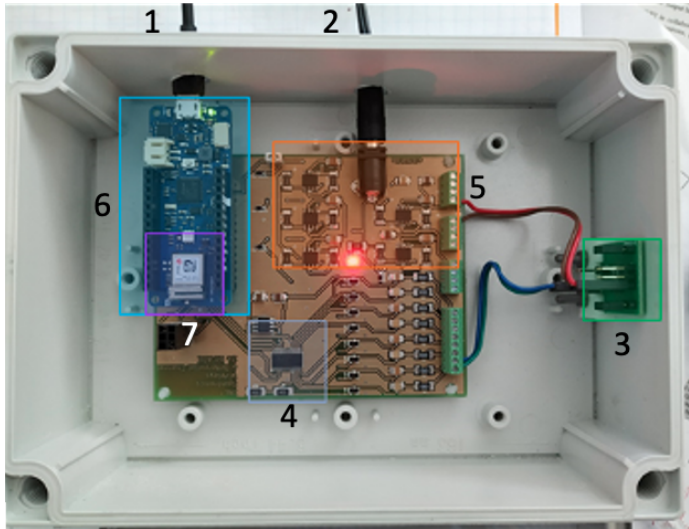
Figure 4. Physical implementation of the magnetoresistive sensor circuit.